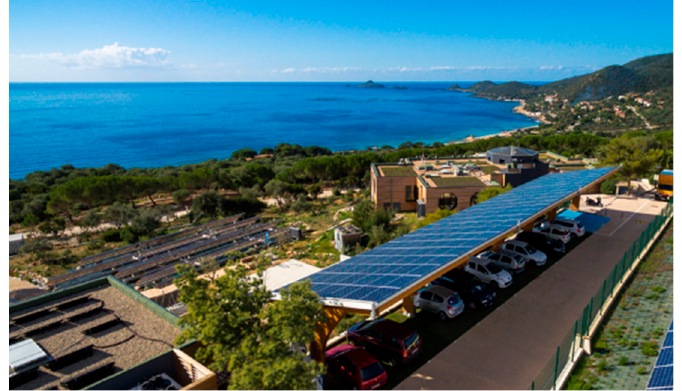
Figure 1. Distributed Generation systems (DG): Photovoltaic (PV) solar shade structure.